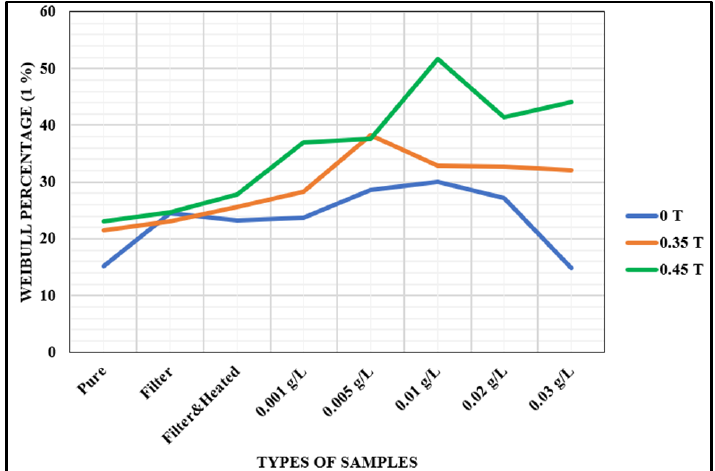
Figure 5. Weibull percentage of 1 % of breakdown voltage.